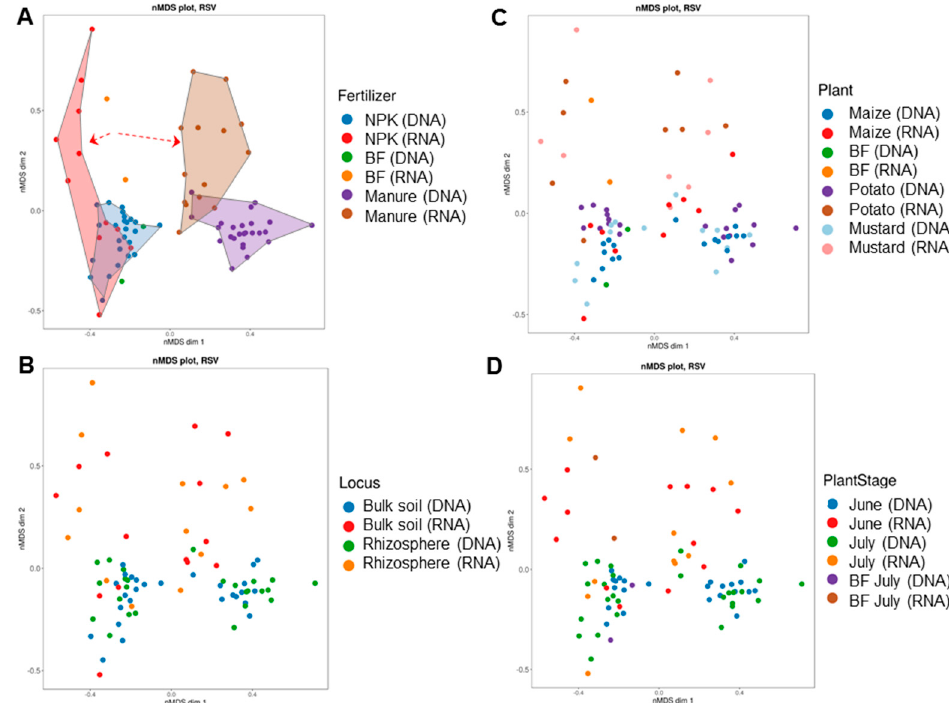
Figure 7. Non-metric multidimensional scaling plots of soil fungal community assembly patterns using the Bray-Curtis (BC) distance matrix as related to ( A ) fertilizer system, ( B ) soil niche, ( C ) crop type, and ( D ) stage of plant development. The dotted arrows indicate the divergence of the bulk soil and rhizosphere mycobiomes under NPK and manure in opposite directions from the control without fertilizers.